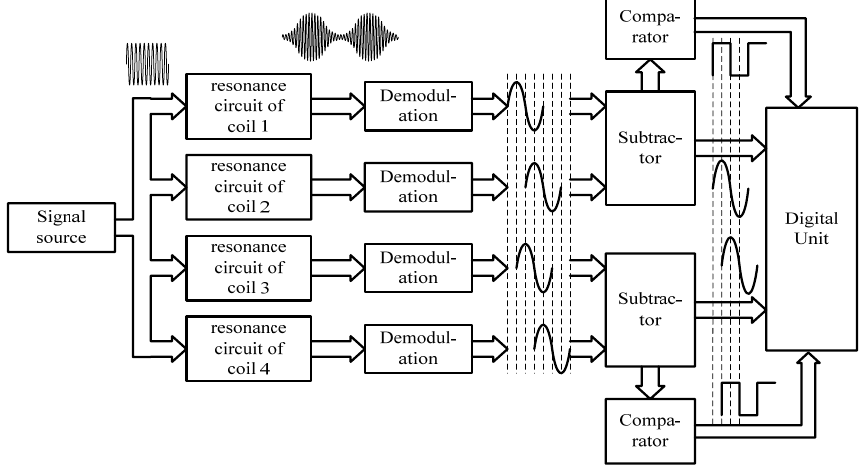
Figure 3. Operating principle of the